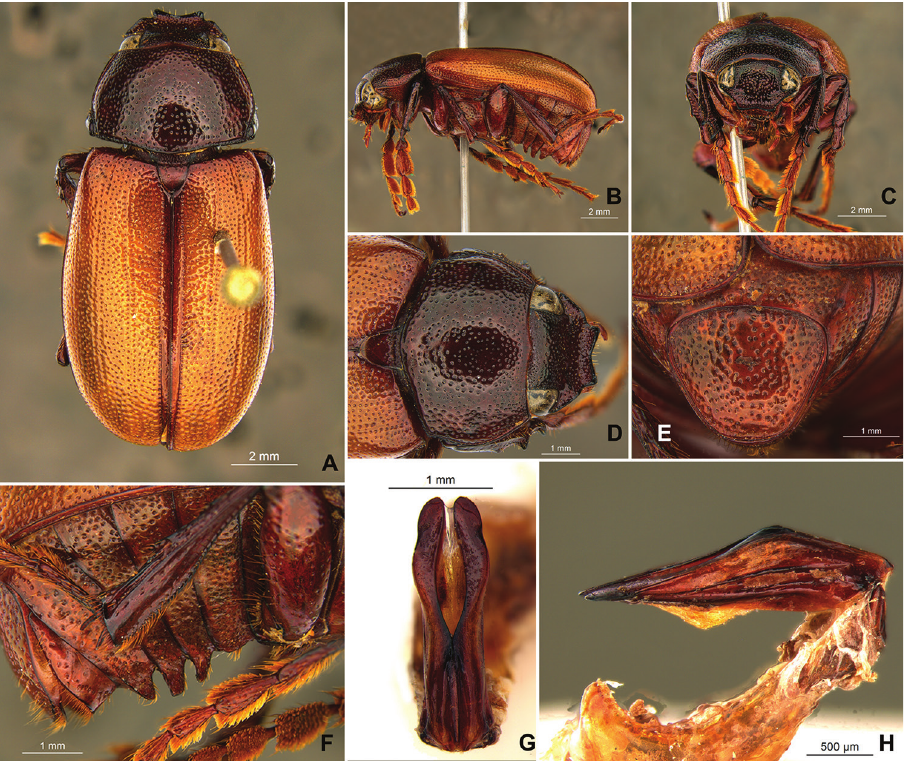
Figure 85. Liogenys grossii Cherman, sp. n. A Dorsal view B Lateral view C Frontal view D Clypeus and pronotum E Pygidium F Abdomen, lateral view G Parameres, dorsal view H Parameres, lateral view.